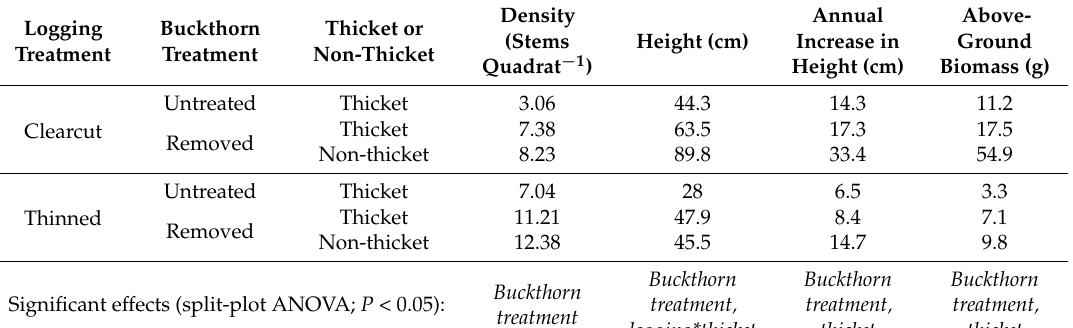
Table 2. Density of eastern white pine seedlings and height, annual increase in height, and aboveground biomass of the tallest white pine seedling per 1 m 2 quadrat in response to logging treatment (clearcut or thinned), buckthorn treatment (untreated or buckthorn removed by cutting or flaming), and presence or absence of buckthorn thicket in treated areas. Values are adjusted means from a split-plot ANOVA with buckthorn treatments nested within logging treatments and dependent variables log e -transformed. n = 19